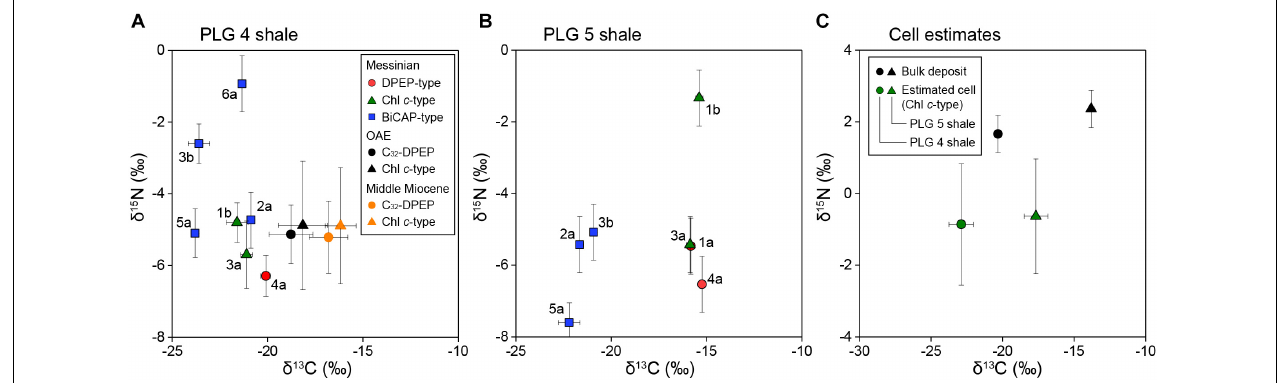
FIGURE 3 | (A,B) Cross plots of the carbon and nitrogen isotopic compositions of purified alkylporphyrins from the PLG shales. The DPEP-type porphyrins are shown by red circles, the Chl c -type by green triangles, and the BiCAP-type by blue squares. Letters next to the symbols refer to the individual porphyrins in Figure 2 . The bars of each symbols represent analytical precisions. Also shown are the isotopic compositions of DPEP and C 30 -17-nor-DPEP (Chl c -type) from the black shales of the Cretaceous Oceanic Anoxic Event and the Miocene siliceous sediments of the eastern margin of the Japan Sea (Kashiyama et al., 2008a,b, 2010). The bars of each symbols represent the range of variation among different samples. (C) Cross plots of the carbon and nitrogen isotopic compositions of the bulk deposits and the source phototrophic cells of compound 3a (Chl c -type), assuming the porphyrins are enriched in 13 C by 1.8 ± 0.8 in 15 N by 4.8 ± 1.4 TABLE 1 | Molecular ion ( m/z ), number of carbons, theoretical C/N weight ratio, measured C/N weight ratio, δ 13 C, and δ 15 N of the bulk sediments and geoporphyrins of the PLG shales in Vena del Gesso, Northern Apennines, Italy. Compound Molecular Ion ( m/z ) Theoretical C/N wt